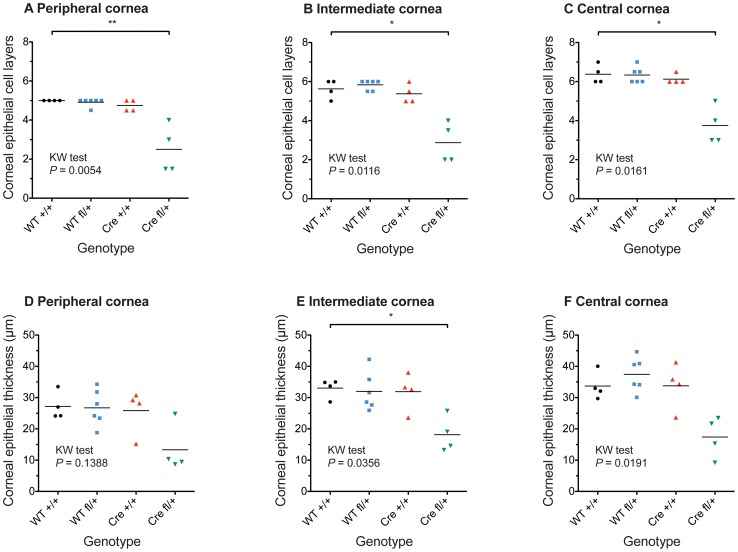
Variation in corneal epithelial thickness in different genotypes from stage-1 crosses.Variation in corneal thickness in 12-week-old mice of different genotypes from Le-CreTg/−; Pax6+/+ × Le-Cre−/−; Pax6fl/+ stage 1 crosses. Variation in (A–C) number of corneal epithelial layers, (D–F) corneal epithelial thickness (µm) at the periphery (A,D), intermediate (B,E) and central (C,F) cornea in 12 week old mice of different genotypes from Le-CreTg/−; Pax6+/+ × Le-Cre−/−; Pax6fl/+ stage 1 crosses. Results are means of two measurements at the periphery, intermediate and central regions of 4–6 eyes (1 eye per mouse) per genotype. Abbreviations: WT +/+ is Le-Cre−/−; Pax6+/+, WT fl/+ is Le-Cre−/−; Pax6fl/+, Cre +/+ is Le-CreTg/−; Pax6+/+ and Cre fl/+ is Le-CreTg/−; Pax6fl/+. Results for all four genotypes were compared by non-parametric Kruskal-Wallis (KW) tests separately for each corneal region (P-values are shown in the figure) and results for WT fl/+, Cre +/+ and Cre fl/+ were compared to WT +/+ by Dunn's multiple comparison post-hoc test: * P<0.05;** P<0.01.